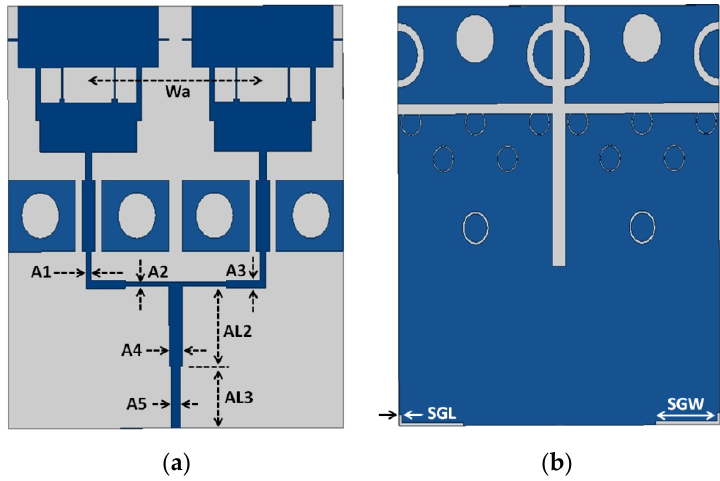
Figure 9. Configuration and parameters of the proposed antenna array and ground plane ( a ) Front view; ( b ) Back view. Table 4. Parameters of the antenna array.